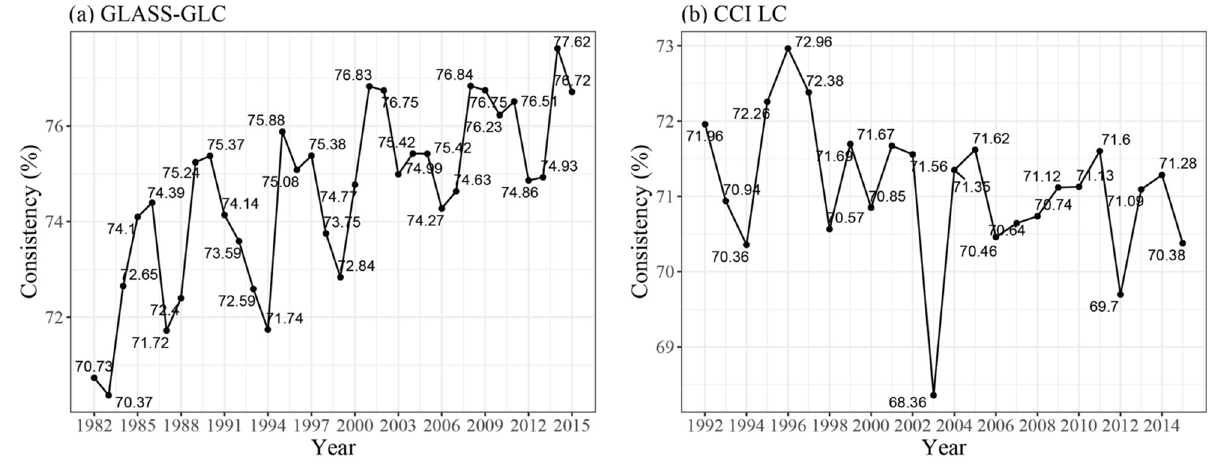
Figure 3. Percentage of consistency between the classification maps with ( a ) GLASS-GLC and ( b ) CCI LC.